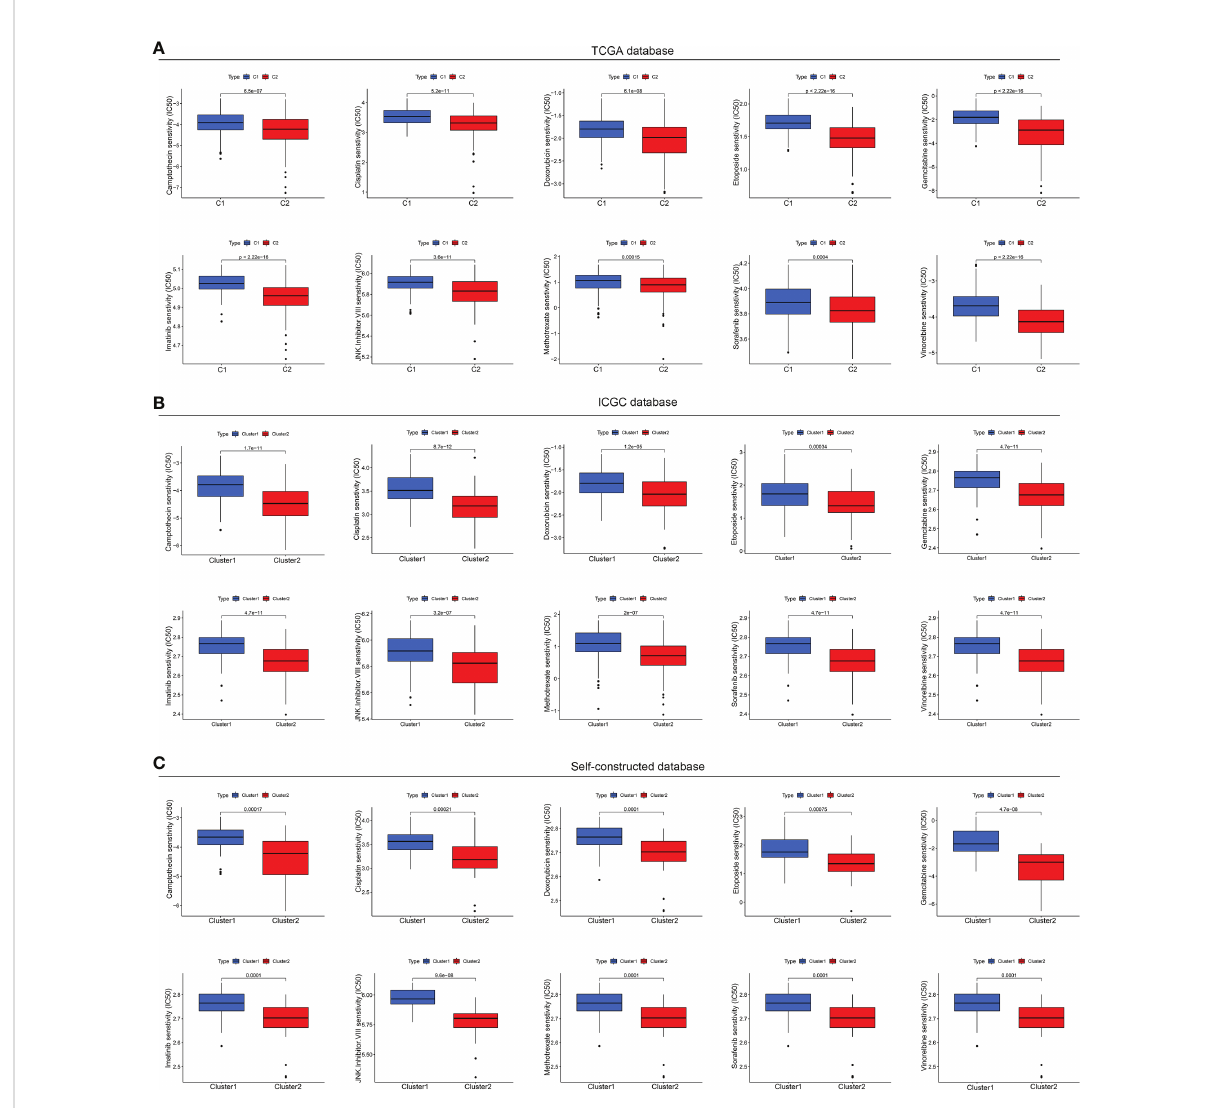
FIGURE 9 Drug sensitivity tests in multiple databases. (A) Drug sensitivity analysis based on TCGA database. (B) Drug sensitivity analysis based on ICGC database. (C) Drug sensitivity analysis based on Self-constructed